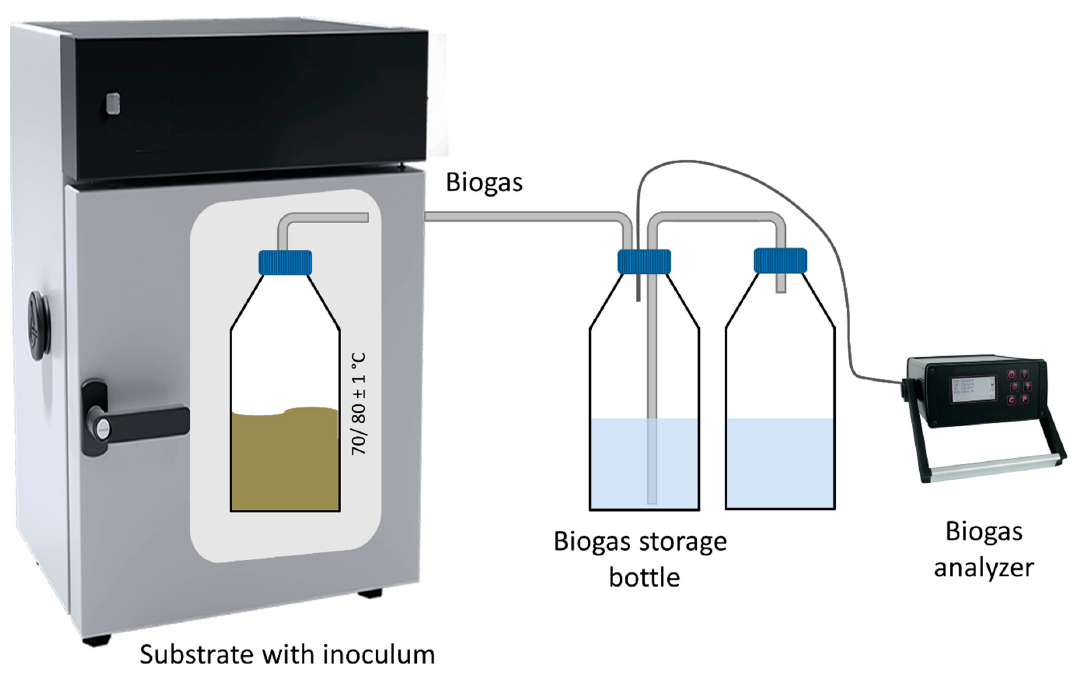
Figure 1. Laboratory setup for biogas production